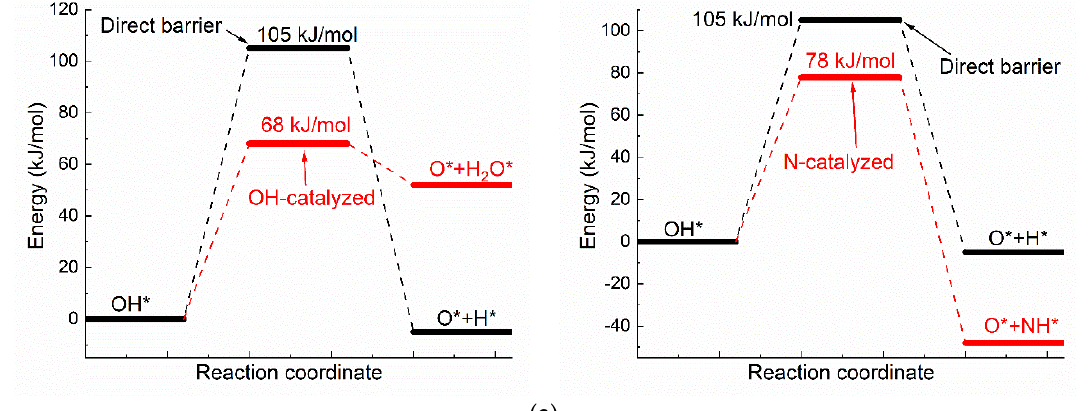
Figure 2. Structures and Bader charges in the oxhydryl dehydrogenation of H x COH with and without co-adsorbed OH: ( a ) x = 0, ( b ) x = 1, ( c ) x = 2, ( d ) x = 3. From left to right: local minimum and transition state structures of H x COH without and with co-adsorbed OH.